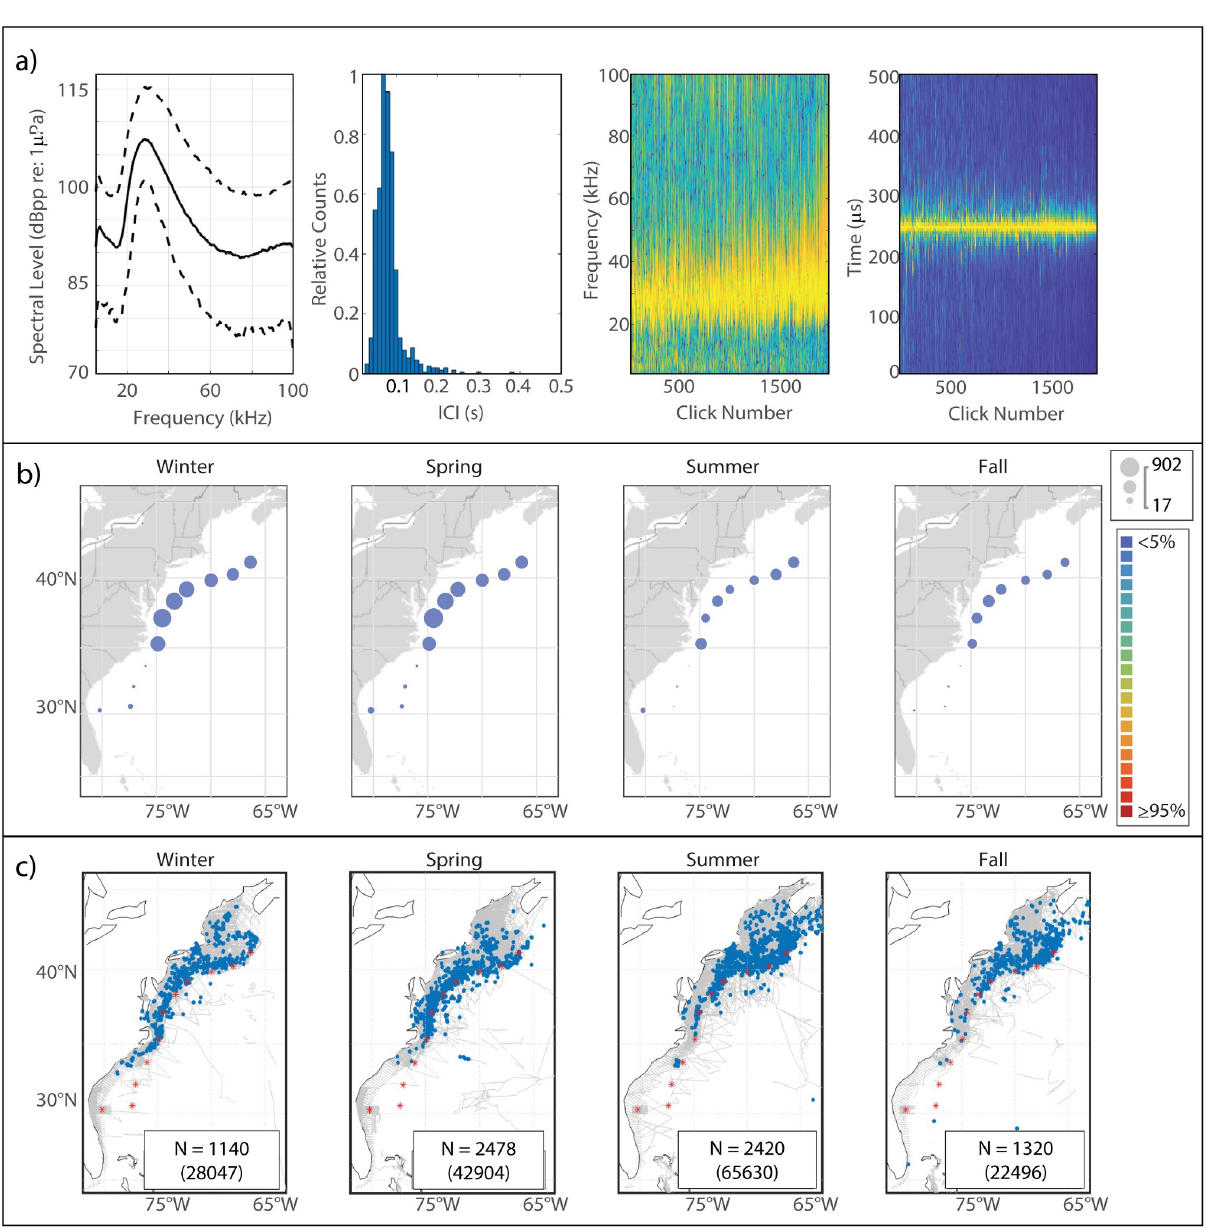
Fig 13. Results for UD28 showing click type (a), acoustic presence (b), and historical sightings of probable species match, short-beaked common dolphin (c). Subplots as in Fig